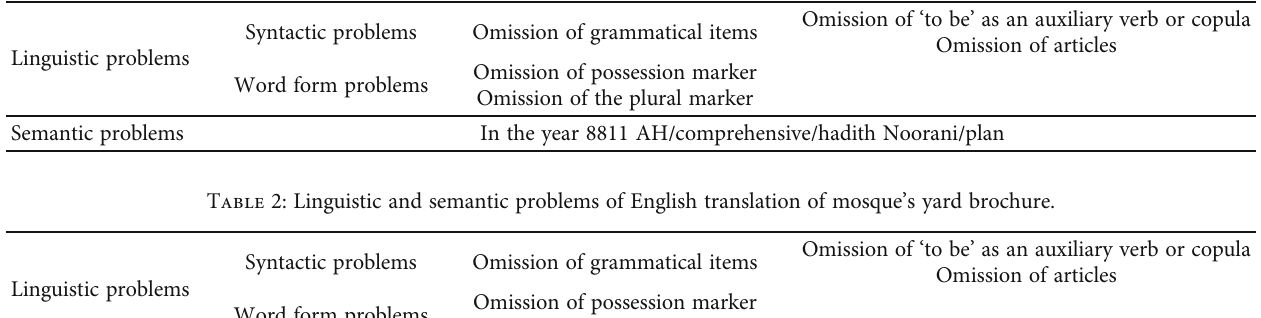
Table 1: Linguistic and semantic problems of English translation of Vakil mosque brochure.